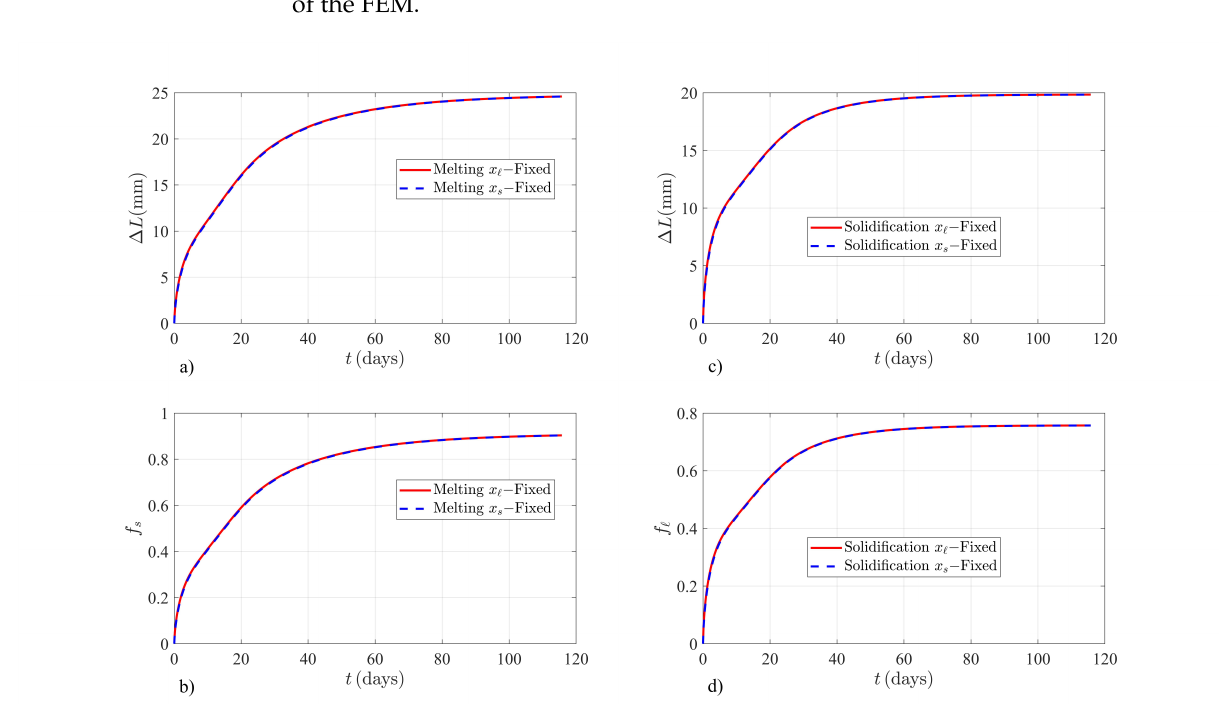
Figure 2. Finite element method solutions to the proposed model for the examples shown in Figure 1. ( a ) Time evolution of the system growth ∆ L in mm and ( b ) fraction of melted solid f s , when the initial interface position is ξ ( 0 ) = 0.30m. ( c ) Shrinkage ∆ L in mm and ( d ) fraction of solidified liquid f (cid:96) , when the initial interface position is ξ ( 0 ) = 0.70m. Solutions are invariant and reach the correct thermodynamic equilibrium values shown through Equations (10) and (11). Table 2. Average energy error (AEE) in Giga-Joules (GJ), upon melting and solidification of KNO